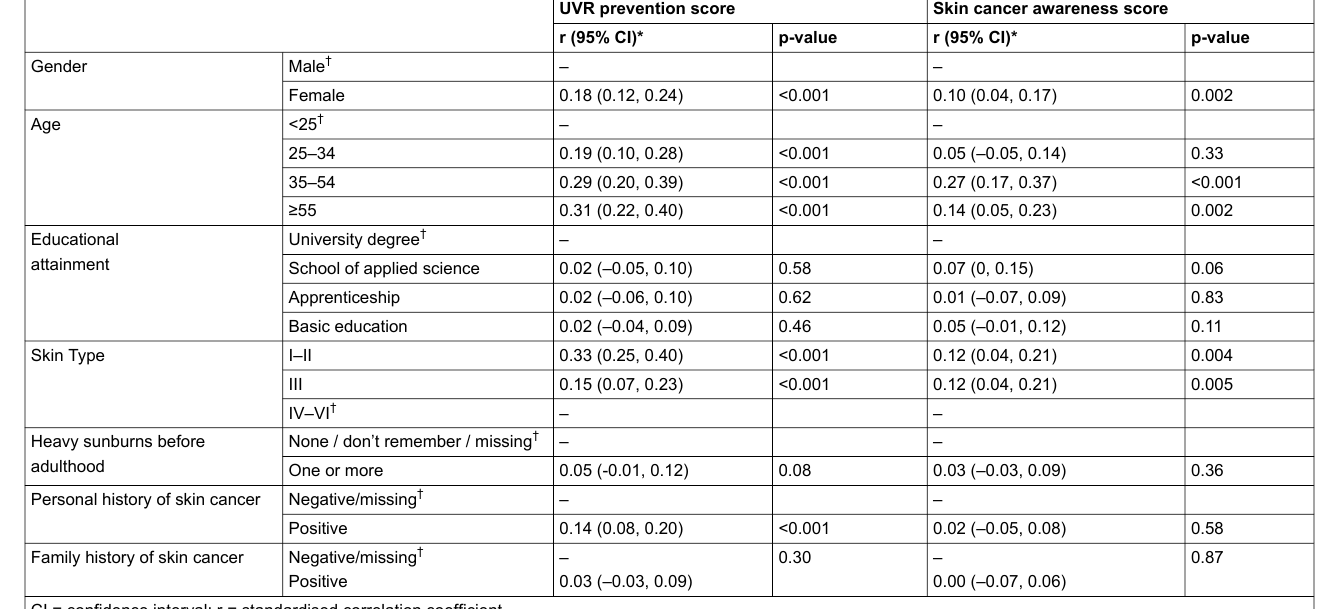
Table 2 : Multivariable analysis of factors associated with ultraviolet radiation (UVR) prevention and skin cancer awareness